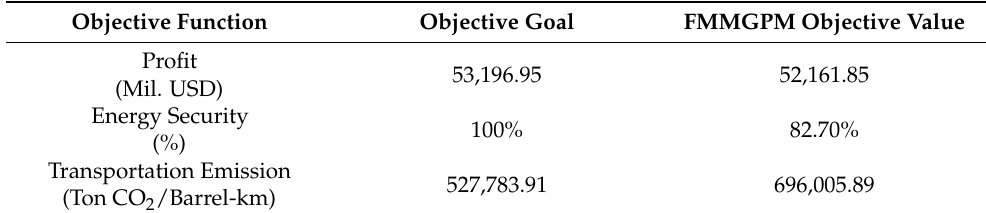
Table 6. FMMGPM objective value.